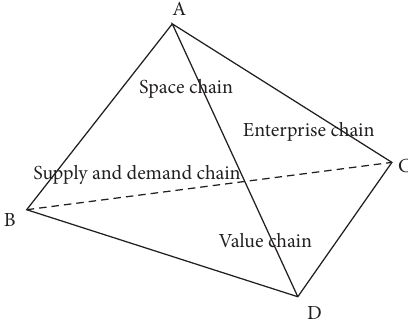
Figure 1: Four dimensions of industrial